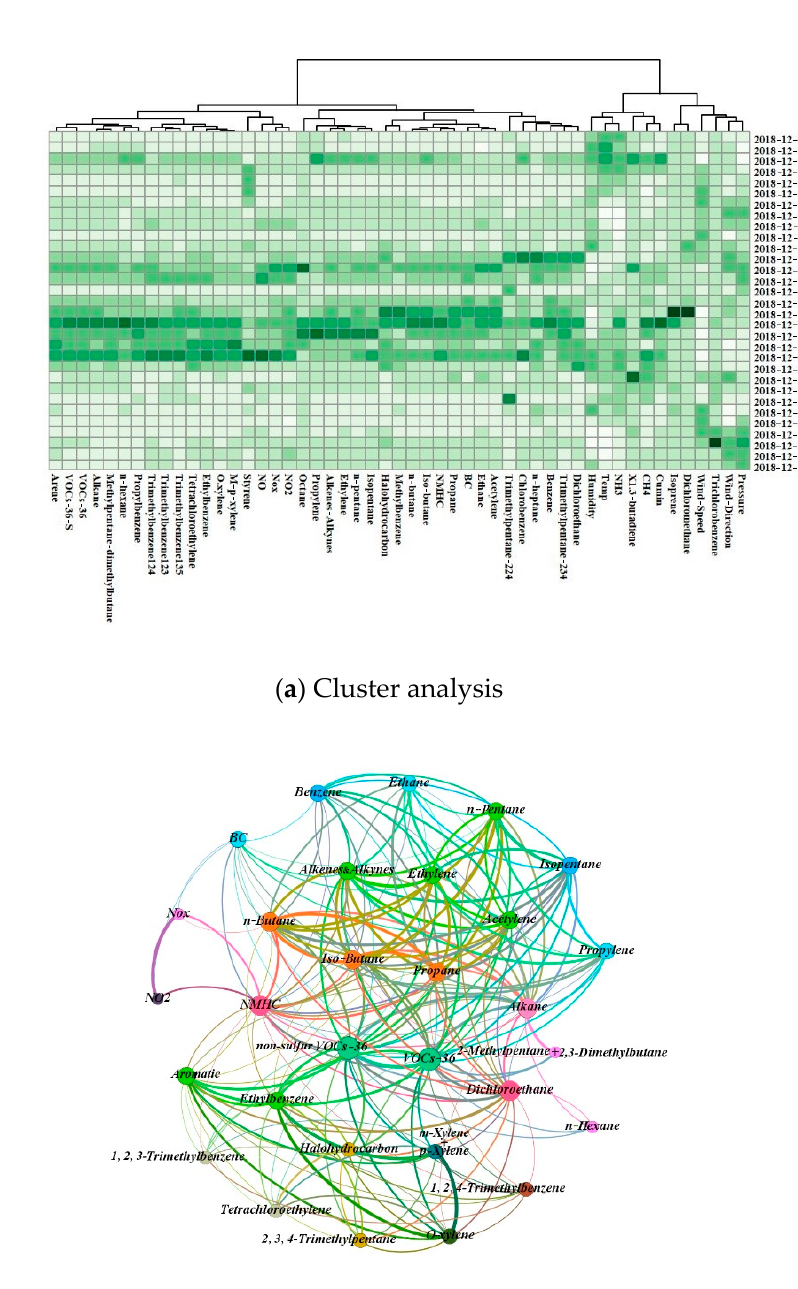
Figure 9. Results of analysis of BC concentrations in